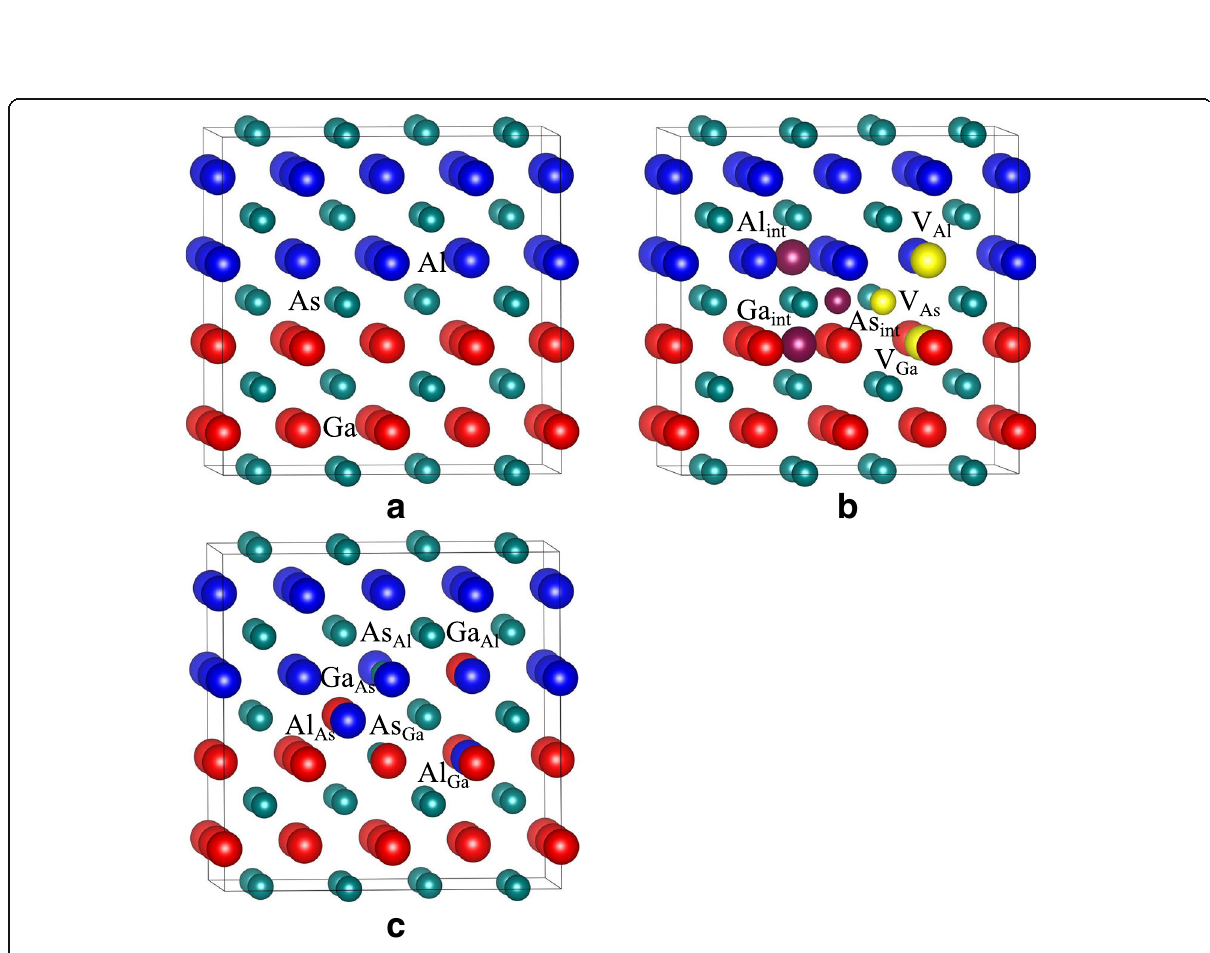
Fig. 2 Schematic view of geometrical structures of a ideal GaAs/AlAs superlattice; b and c GaAs/AlAs superlattice with different point defects. X Y : (X, Y = Ga, Al, or As) X occupying the Y lattice site; V X : X vacancy; X int : X interstitial. The yellow and carmine spheres represent the vacancy and interstitial defects, respectively